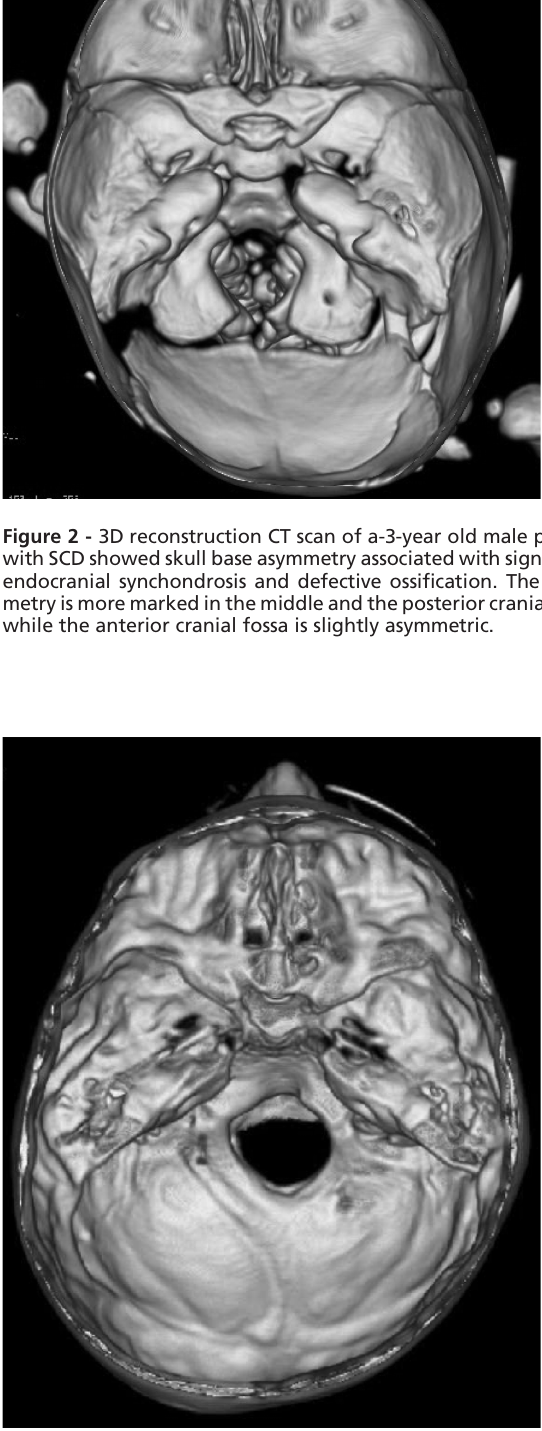
Figure 3 - A 3 D reconstruction CT scan showed skull asymmetry in a 14-year-old patient (deformational plagiocephaly) without synostosis. A 3D reconstruction CT scan of the endocranial base showed asymmetric 3D position of the external acoustic meatus. The asymmetry is more marked in the middle and the posterior cranial fossa while the anterior cranial fossa was slightly